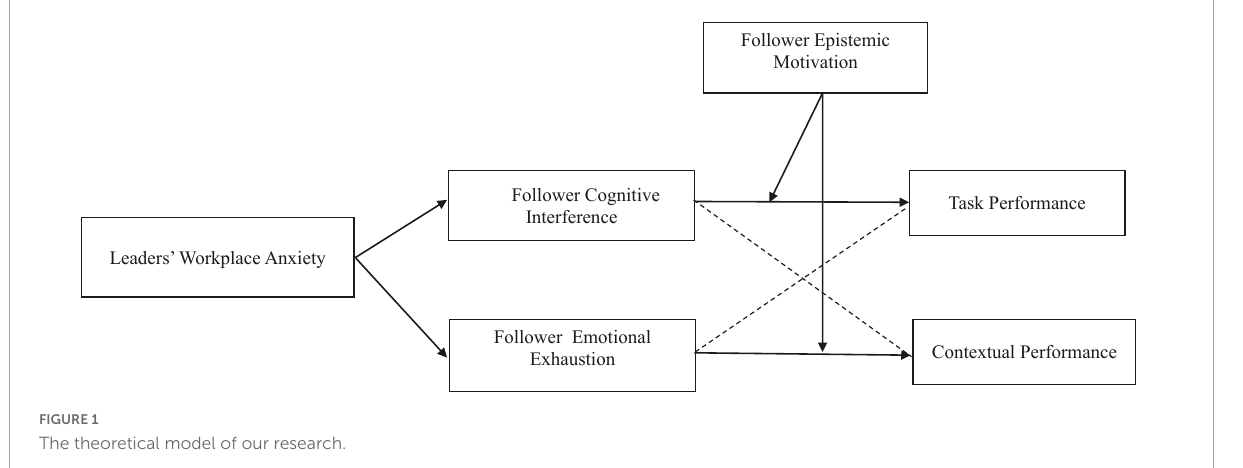
FIGURE1 The theoretical model of our